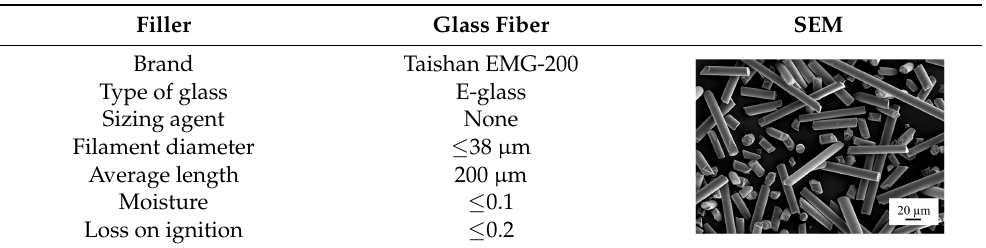
Table 1. Milled glass fiber.